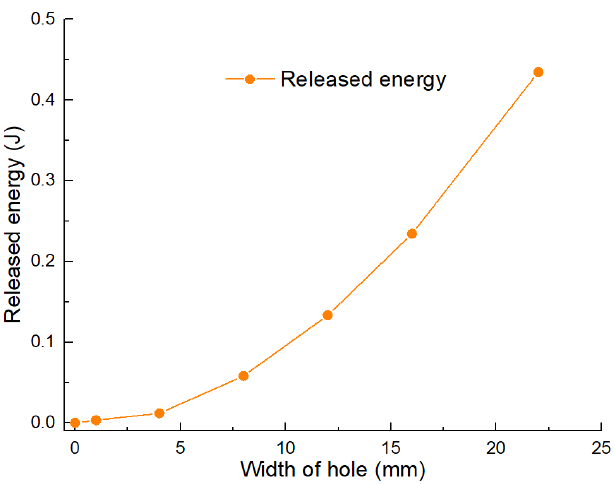
Figure 11. Strain energy release caused by different width w of excavation hole.